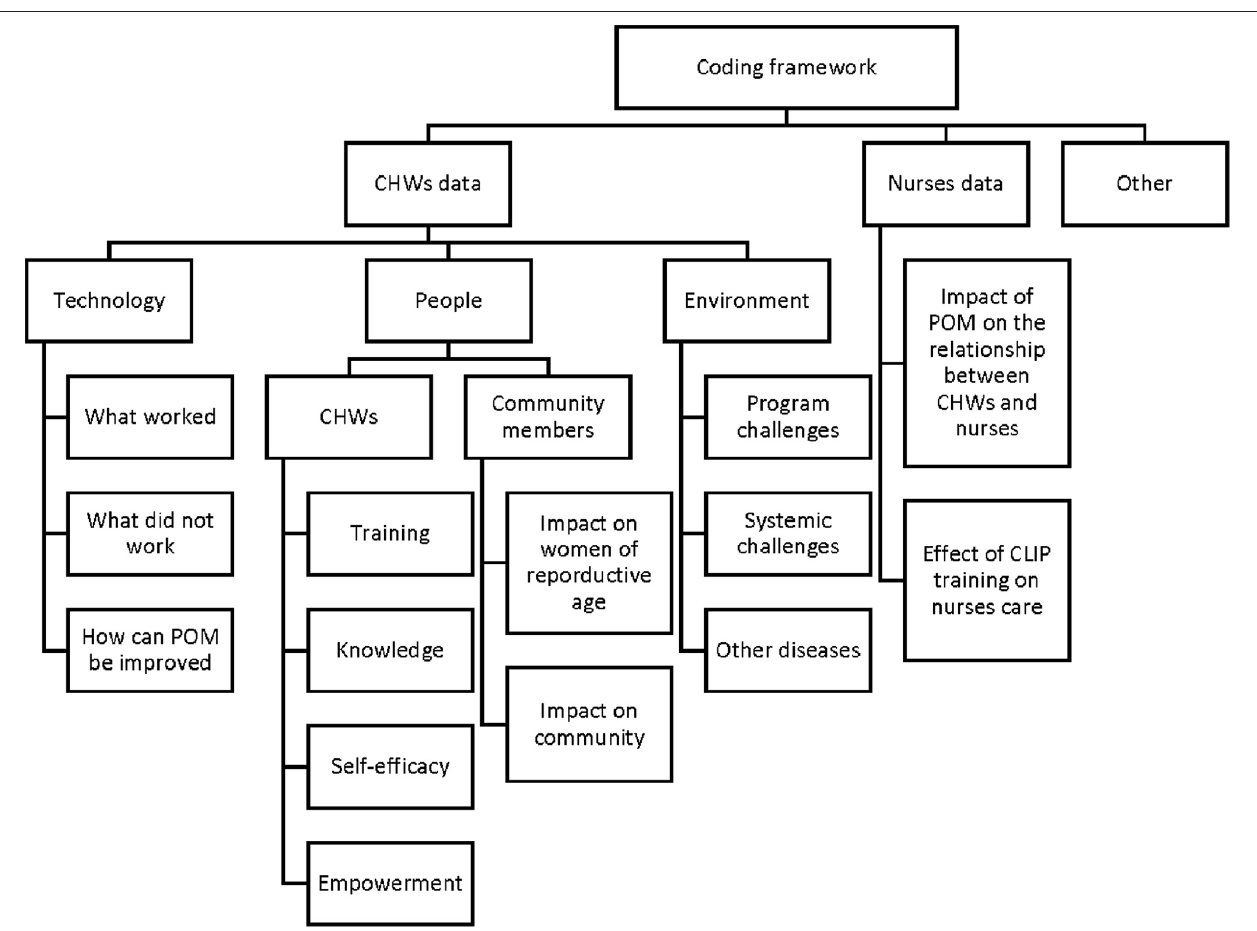
FIGURE 1 | Qualitative coding